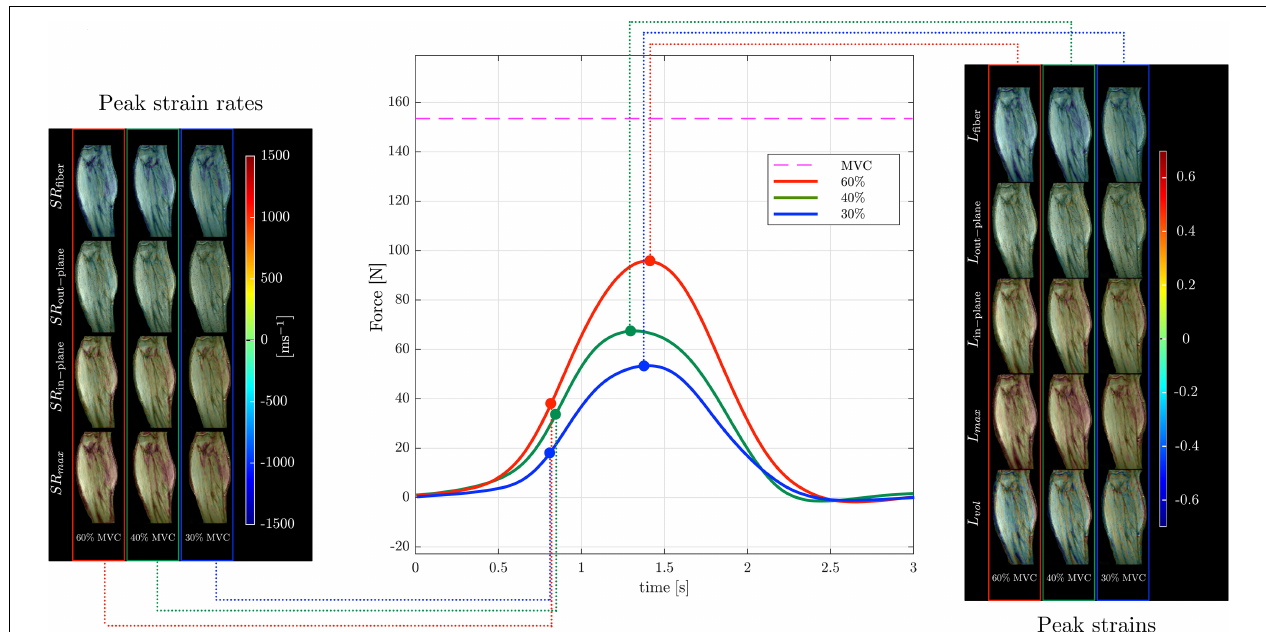
FIGURE 4 | Temporal variation of forces exerted by a senior subject averaged during the MR data acquisition for different force levels (center panel) along with corresponding strain (right panel) and strain rate (left panel) colormaps at the peak values (of L fiber or SR fiber ) during the contraction phase of the dynamic cycle for 60% (left column), 40% (middle column), and 30% MVC (right column). The colormap bars are shown in each panel. The temporal frames at which the peaks during contraction occurred for strain and strain rate are marked on the force curves. While the peak in strains occur at the maximum force reached, peak in strain rates occur earlier and roughly correspond to the maximum slope of the force-time curve in the contraction cycle. The subscripts, fiber , out - plane , in - plane and max , vol for SR and L are explained in the text. Colormaps of the strain and strain rate indices for the entire MR acquisition cycle are presented in Supplementary Figure S4